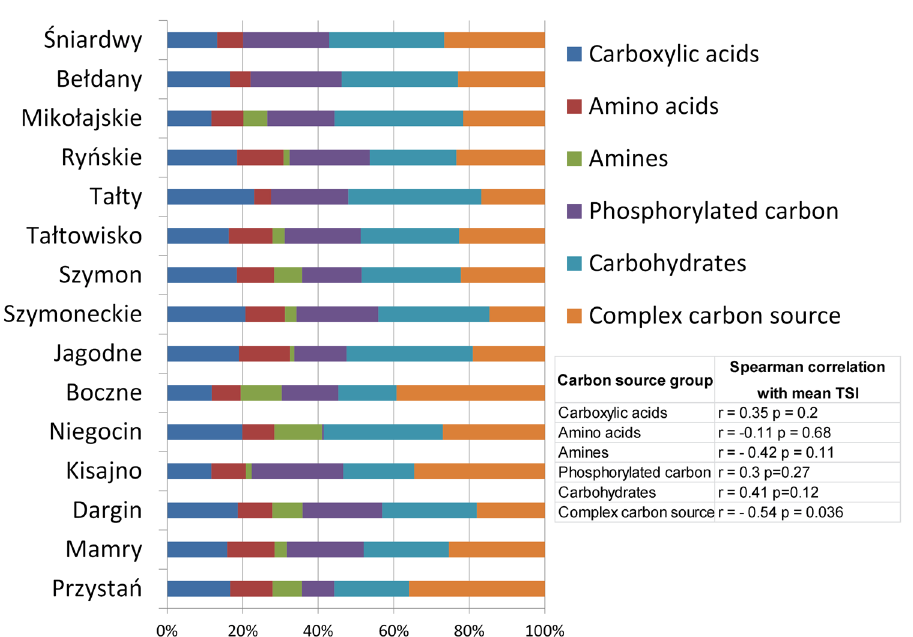
Figure 4. The average relative respiration of carbon sources assigned to the basic groups of compounds. Only the relative respiration rates of complex carbon sources were significantly negatively correlated with the mean